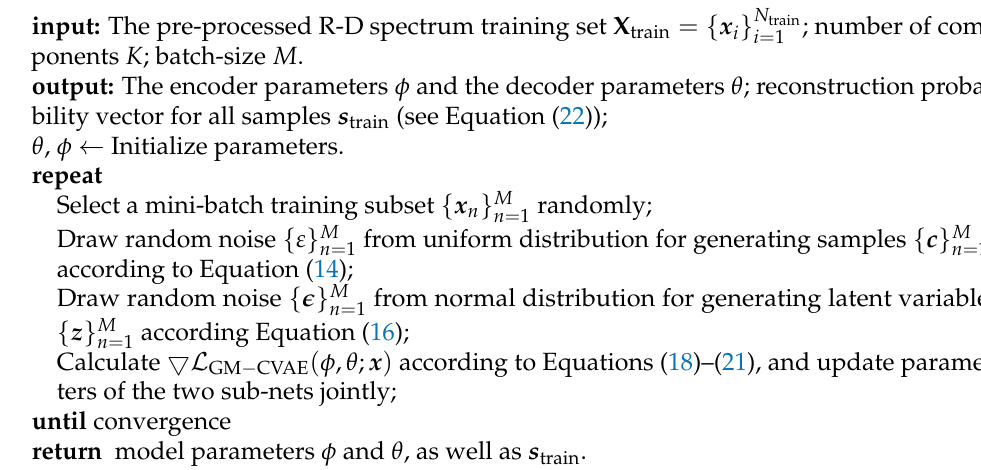
Algorithm 1 : GM-CVAE Training